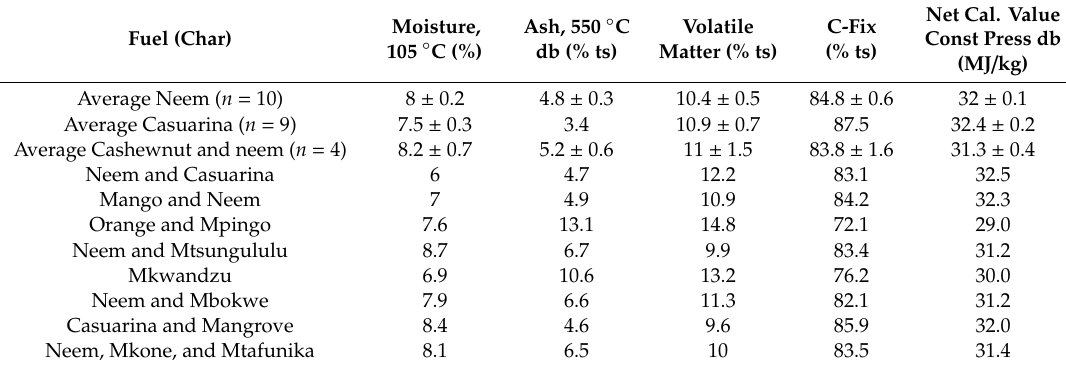
Table 3. Combustion properties of produced